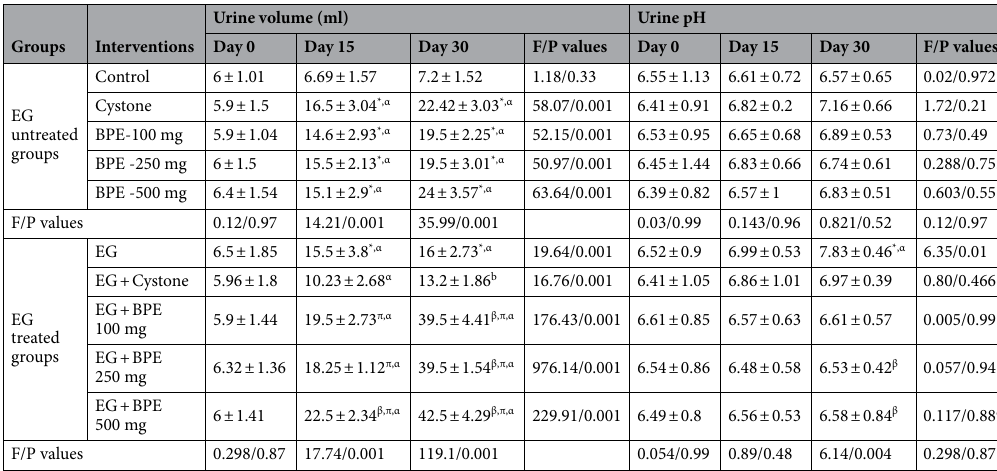
Table 4. Effect of interventions on urine volume and pH. * P < 0.05 compared to EG untreated-control group. # P < 0.05 compared to EG untreated-cystone group. β P < 0.05 compared to EG treated group. π P < 0.05 compared to EG treated-EG + cystone group. α P < 0.05 compared to day 0.